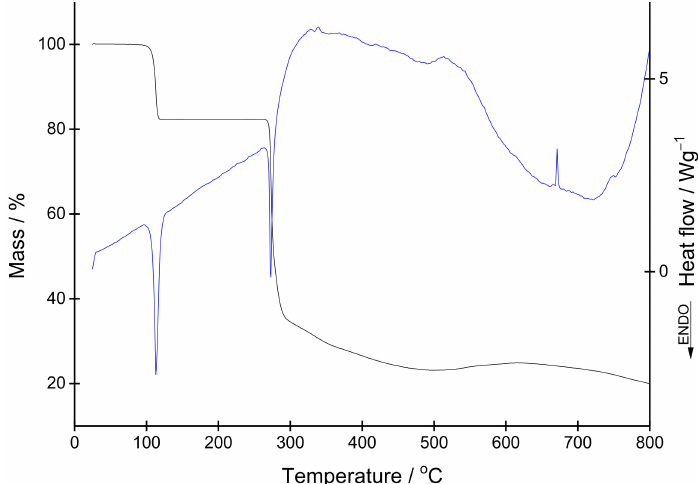
Figure 4. TG-DSC diagram for trans -[Cu(quin) 2 (EtOH) 2 ] ( 1